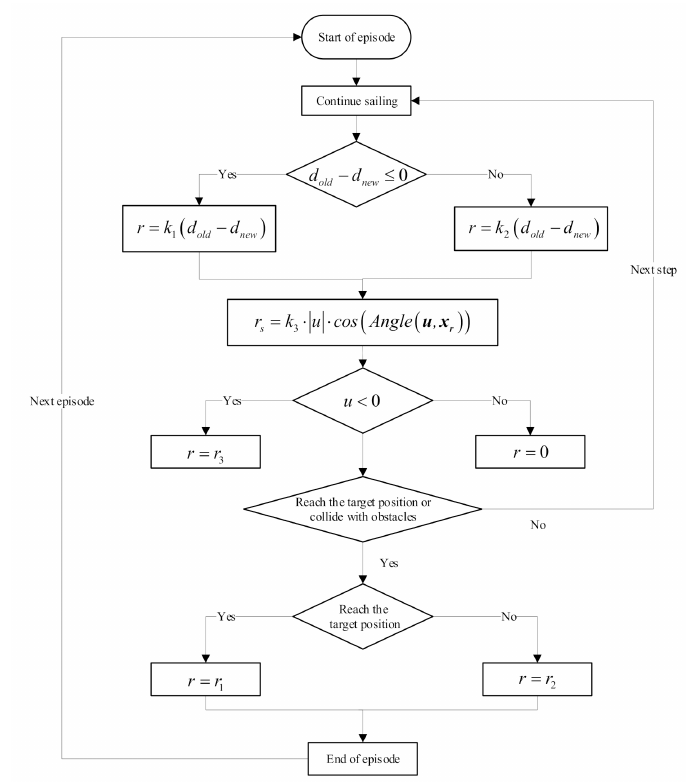
Figure 6. Flow chart of obtaining